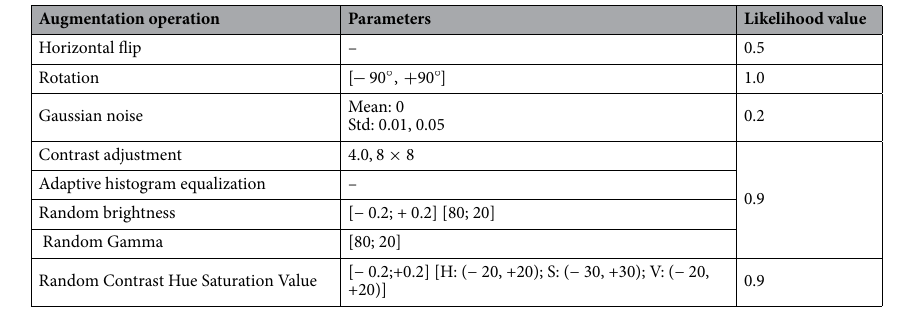
Table 2. A summary of the augmentation operations.